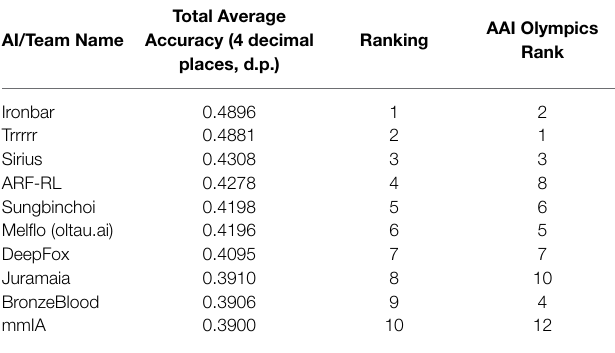
TABLE 2 | Rankings of 30 AI agents involved in this study compared to ranking in AAI Olympics 2019